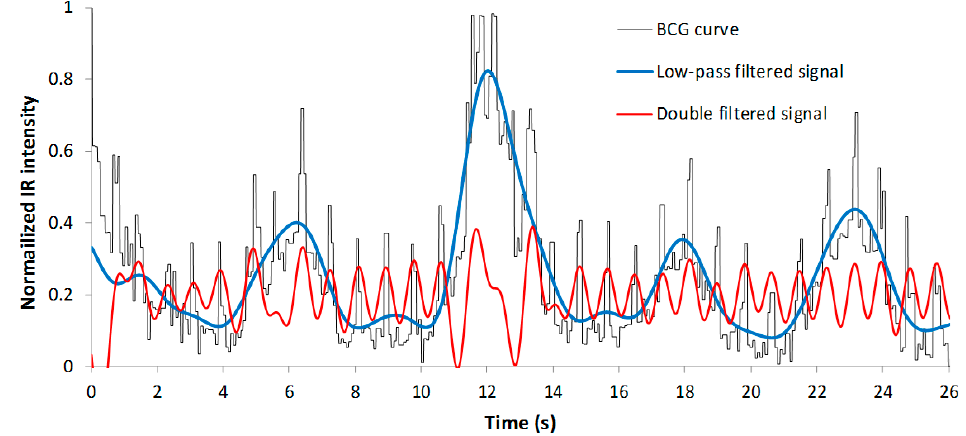
Figure 8. Signals generated after filtering the BCG curve for the prediction of the BR and HR.